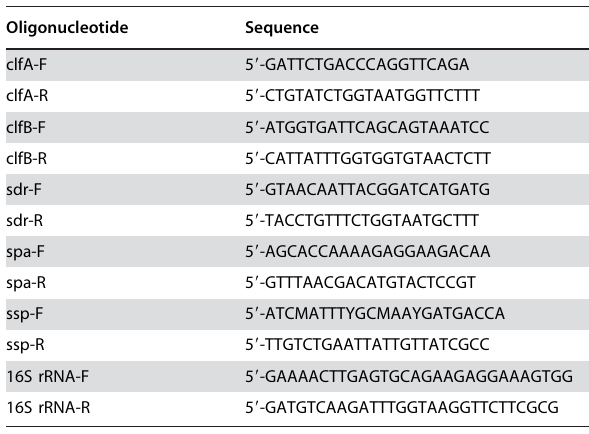
Table 2. Oligonucleotides used in this study. .. ... .... ... ... .... ... ... .... ... ... .... ... ... .... ... ... .... ... ... ....